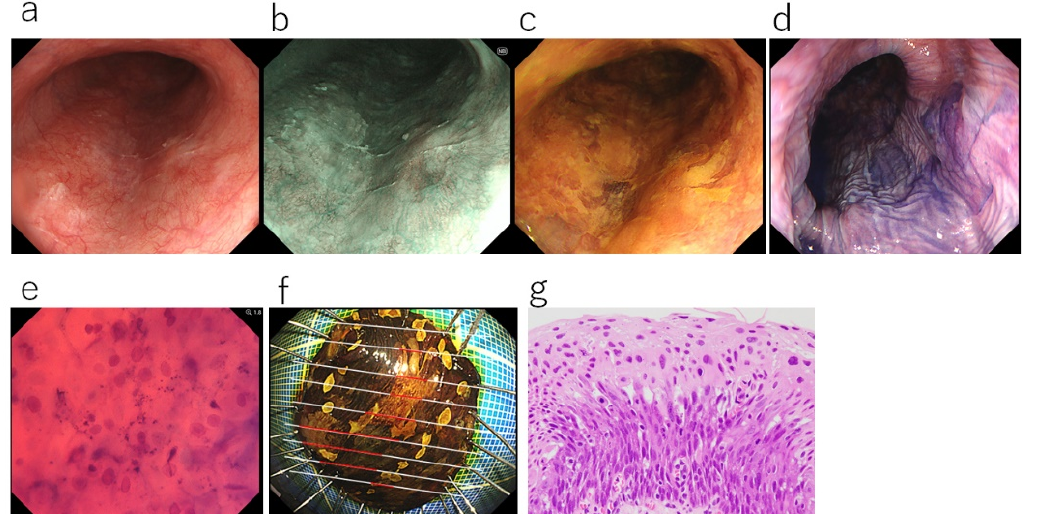
Figure 4. A case in which toluidine blue staining was useful for diagnosing the extent of esophageal cancer: ( a ) White light observation. Whitish and rough mucosa is evident, but the boundary of the esophageal carcinoma is unclear. ( b ) Narrow-band imaging (NBI). The lesion is not delineated as a brownish area and its boundary is unclear. ( c ) Iodine staining. The lesion is a mixture of unstained and weakly stained areas, and the boundary is also unclear. ( d ) Toluidine blue staining shows the lesion as a dark stained area with a well-demarcated border. ( e ) Ultra-high-magnification observation using the EC (toluidine blue staining, ×900). The area darkly stained with toluidine blue was confirmed to be esophageal carcinoma because of increased nuclear density with nuclear abnormality (nuclear atypia). ( f ) Resected specimen after endoscopic treatment (iodine staining). Unstained and weakly stained areas are intermixed. The cancerous area (red line) matches the area darkly stained with toluidine blue. ( g ) The histological diagnosis was squamous cell carcinoma in situ (0-IIb, T1a-EP, HE staining, ×400).